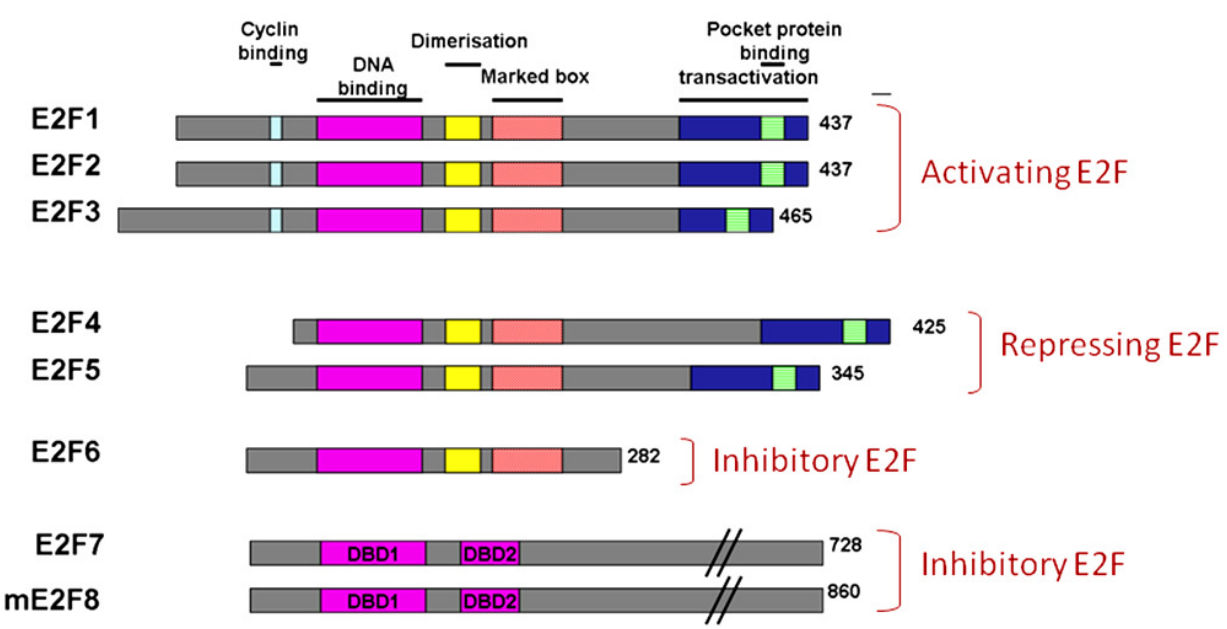
Figure 2. Domain organization of activating, repressive or inhibitory amino acid is indicated on the right. Same colour boxes indicate homologues